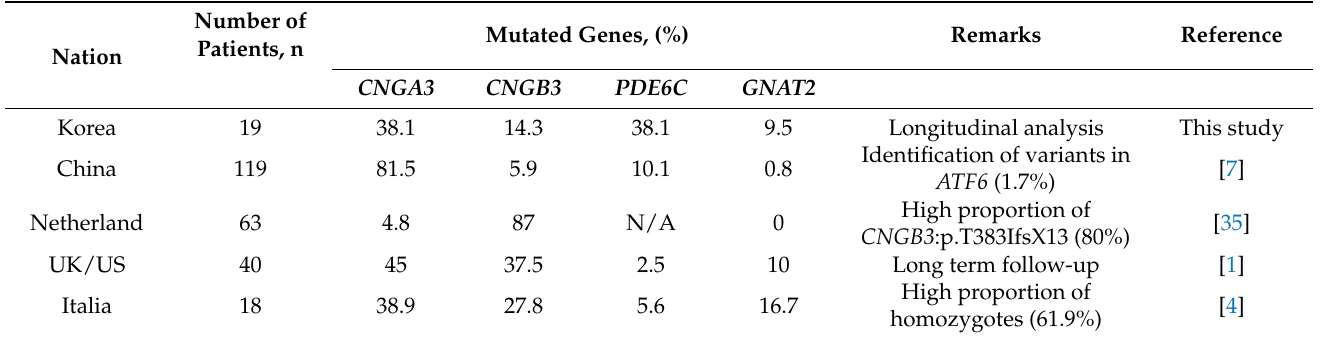
Table 5. Profiles of patients with achromatopsia